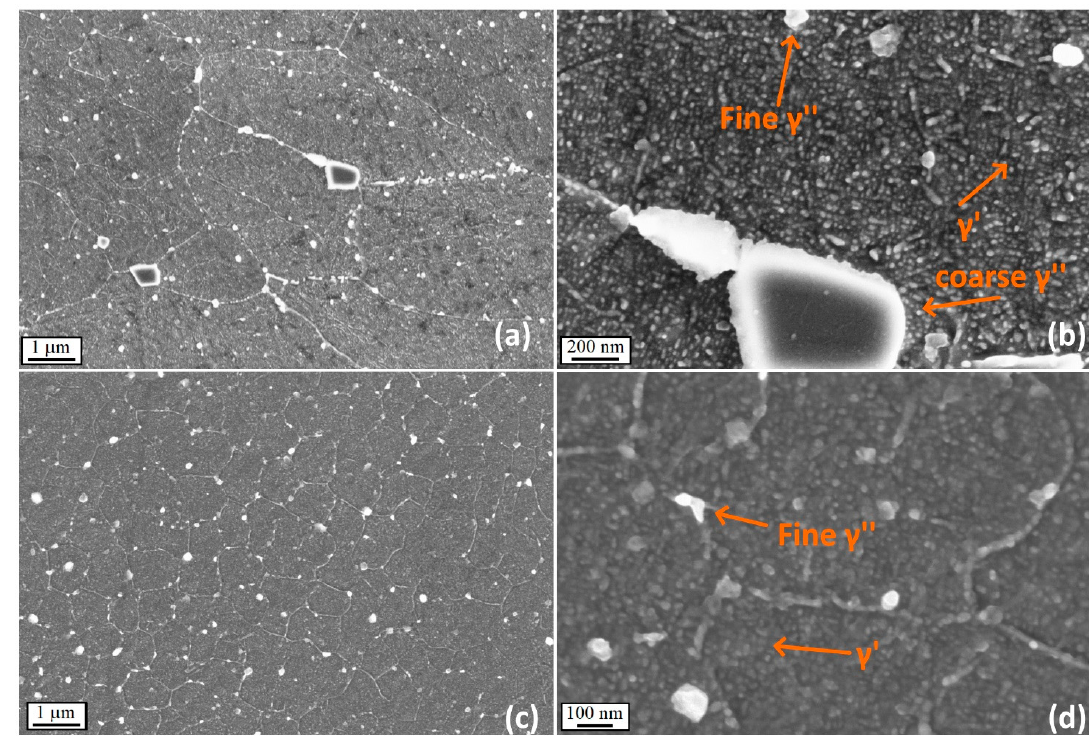
Figure 10. Microstructure after solution annealing at 1065 °C followed by the first aging at 720 °C and second aging at 520 °C for 8 h at different magnification: low ( a ) and high ( b ). A second aging at 630 °C for 8 h at different magnification: low ( c ) and high ( d ).